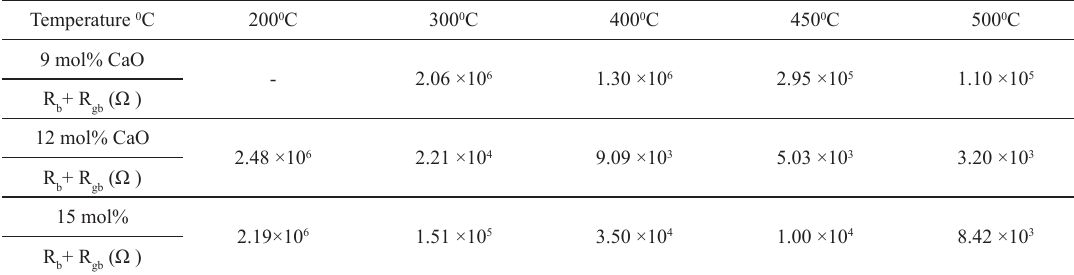
Table 4. Total (bulk and grain-boundary) resistance of the 9, 12, 15 mol% CSZ.